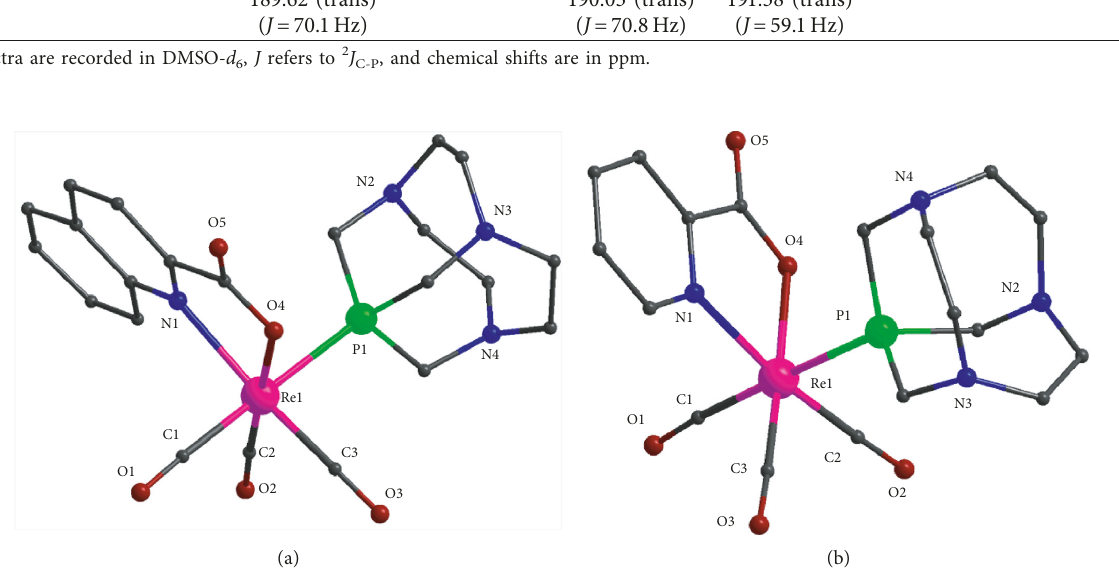
Figure 1: Partially labelled plots of 1b (a) and 2b